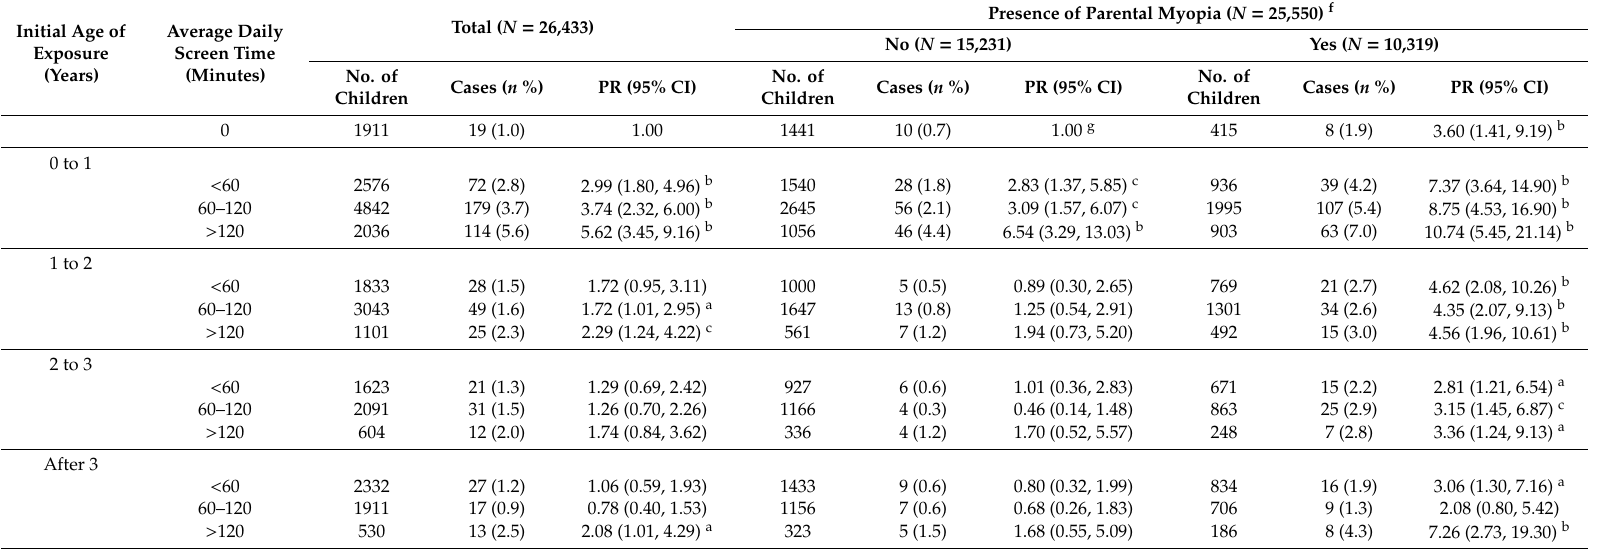
Table 2. Association between initial age of exposure, average daily screen time and preschool myopia e